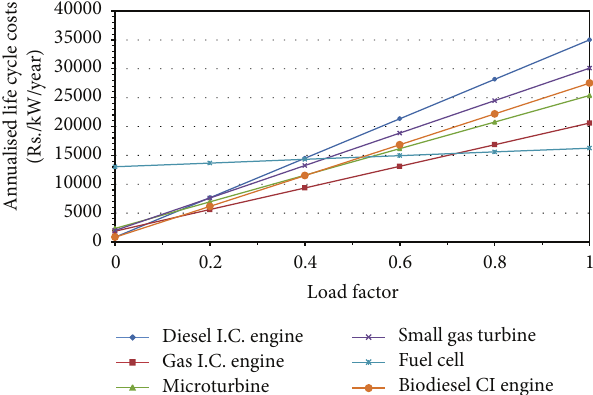
Figure 5: Comparison of annualised life cycle costs for different technological options when only DG is considered (discount rate (𝑑) = 30 %) for the month of January 2013.